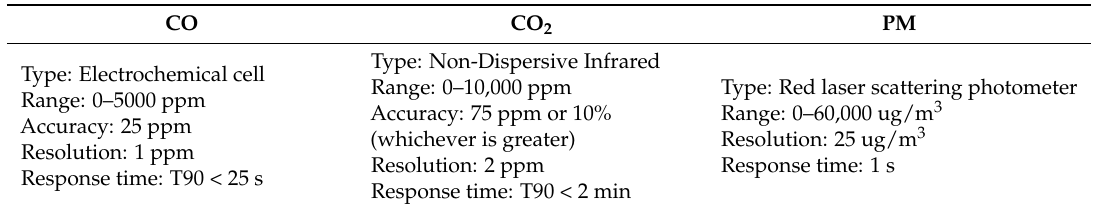
Table 1. Portable Emission Monitoring System (PEMS)